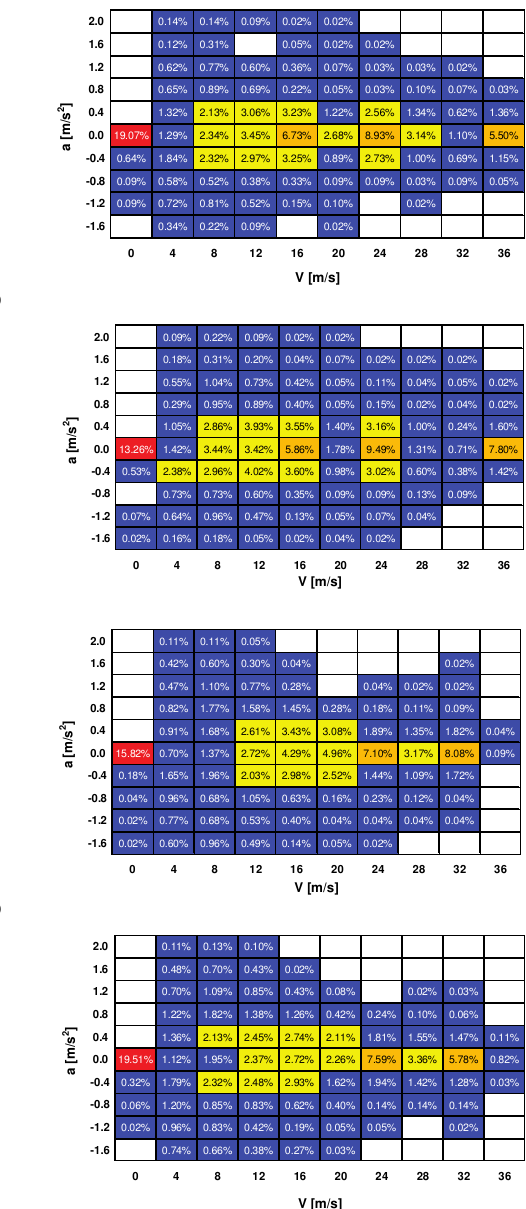
Fig. 6. Comparison between the average urban test section drive speed (a), the total test drive duration (b) and the vehicle stop participation in the urban section with the indication of limit values (required) for all the drives as well as the average value